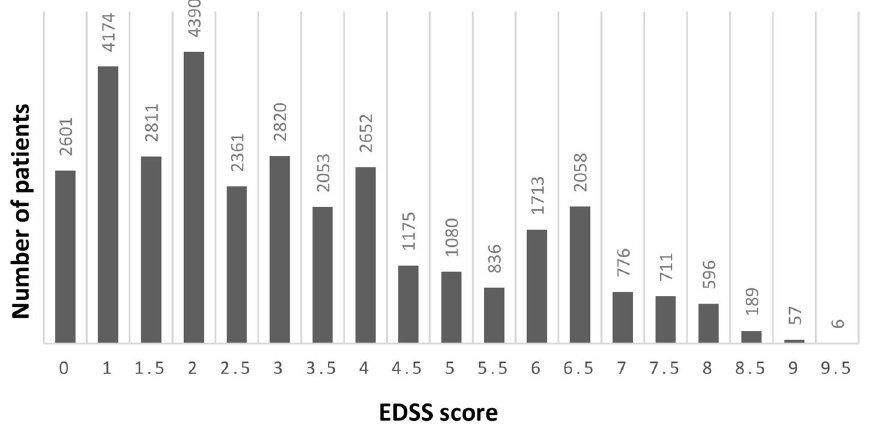
Figure 3. Current EDSS distribution among patients (n = 33,059) in the GMSR. EDSS expanded disability status scale, GMSR German Multiple Sclerosis registry.